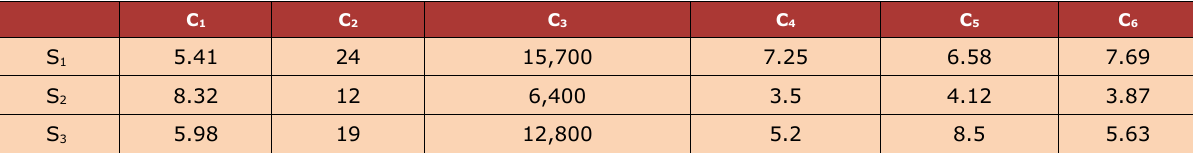
Table 2. Final decision